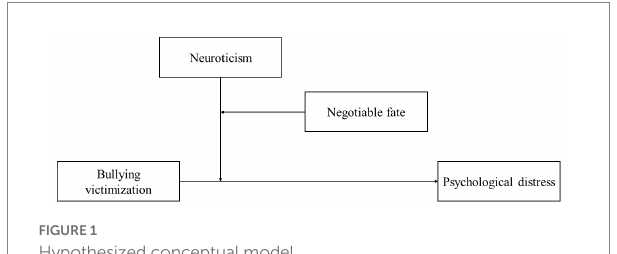
FIGURE 1 Hypothesized conceptual